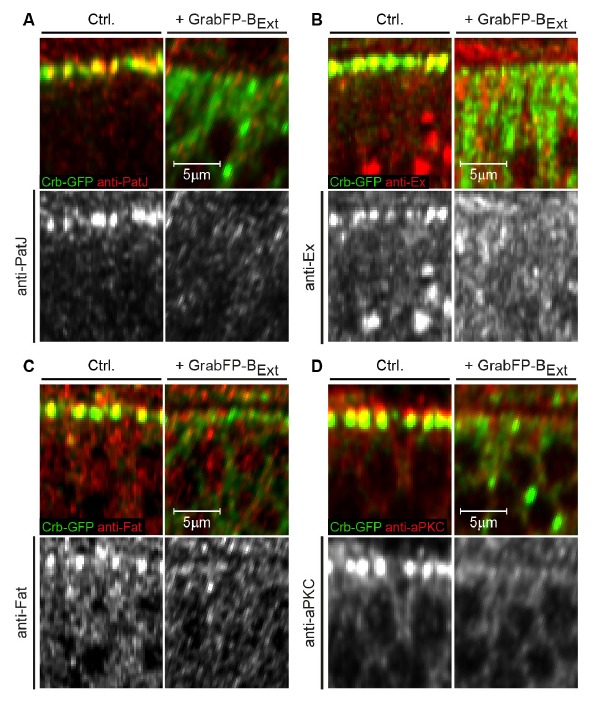
Mislocalization of Crb-GFP affects the localization of apical Crb interaction partners.(A-D) Optical cross-sections of Crb-GFP (green) homozygous GFP-tagged wing discs showing the anterior control compartment (Ctrl., left) and the posterior compartment expressing GrabFP-BExt (right). Discs were stained for the Crb interacting proteins PatJ (A), Expanded (Ex, B), Fat (C) and aPKC (D). In all cases, loss of apical Crbs due to mislocalization resulted in a striking reduction of the apical levels of all Crb interactors tested. Interestingly, no basolateral increase in PatJ, Ex, Fat or aPKC is observed, suggesting that there are control mechanisms excluding these proteins from the basolateral compartment.